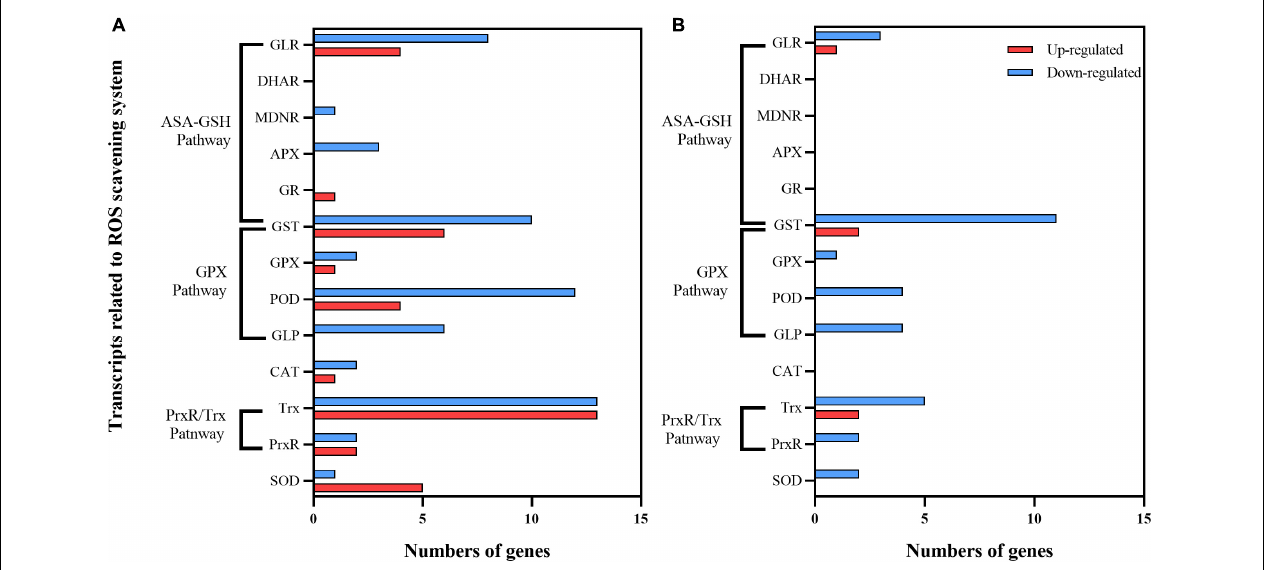
FIGURE 10 | ROS scavenging system of (A) Mingui 1 and (B) Mingui 2 under enhanced UV-B radiation.